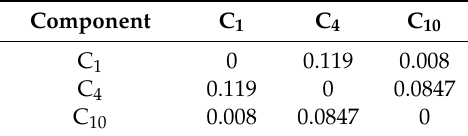
Table 3. Binary interaction parameters for the C 1 / C 4 / C 10